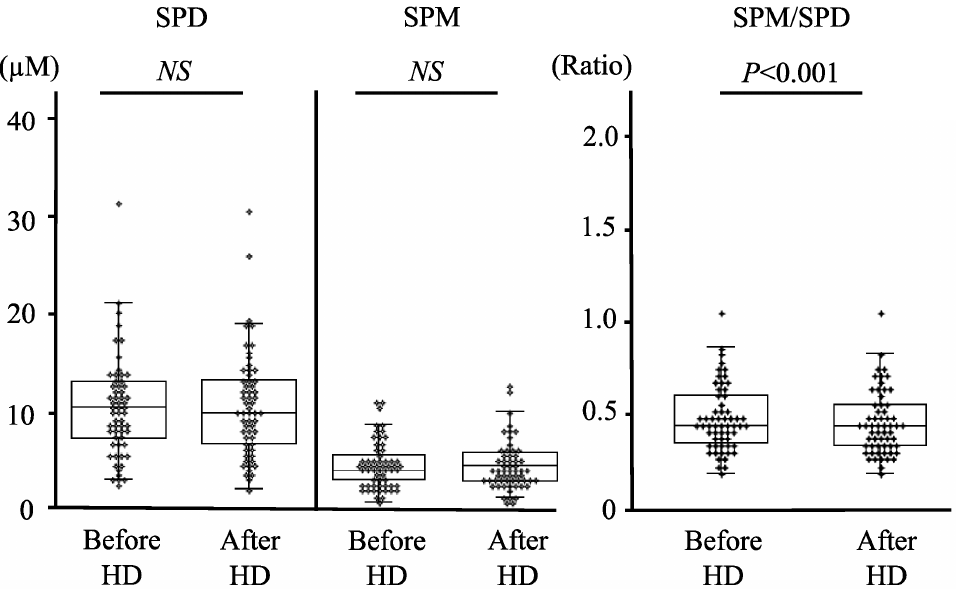
Figure 2. Box and whisker plot and scatter plot of whole-blood SPD, SPM, and SPM/SPD before and after hemodialysis. For each box, the interior line shows the median, and the edges of the box are the estimates of the first and third quartiles. The whiskers extend to the most extreme data points